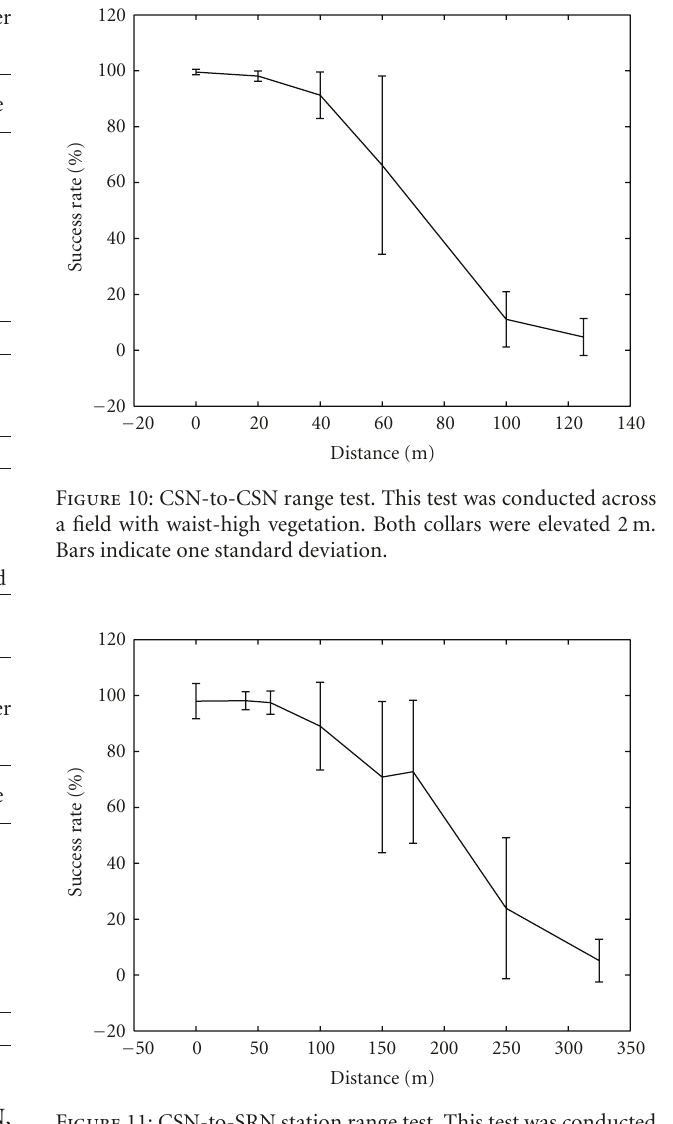
Figure 11: CSN-to-SRN station range test. This test was conducted across a field of waist-high vegetation. The base station was equipped with a high-gain (12 dBi ) directional antenna. Both nodes were elevated 2m. Bars indicate one standard